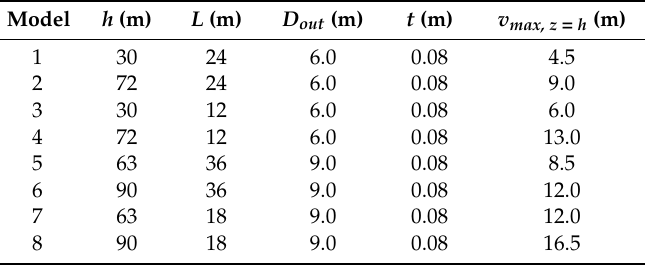
Table 6. Calibration space for the application case.